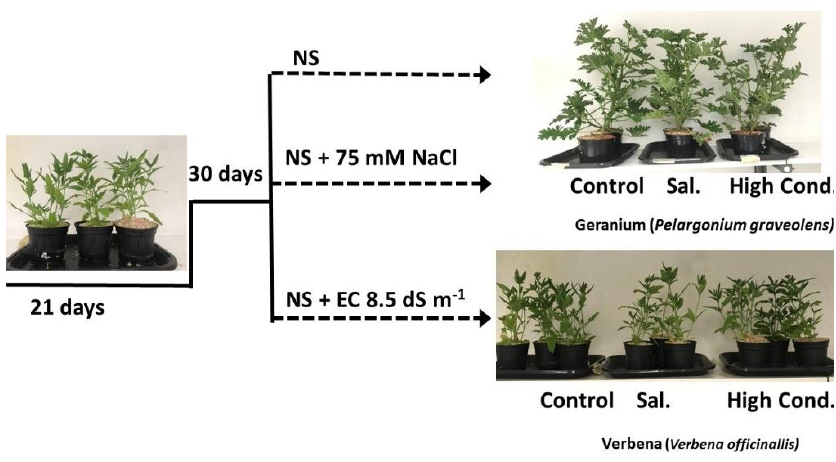
Figure 1. Experimental setup of the effects of salinity (Sal.; 75 mM NaCl) and high electrical conduc- tivity (High Cond.; 8.5 dS m − 1 ) on geranium and common verbena plants grown hydroponically in perlite substrate. NS indicates nutrient solution.